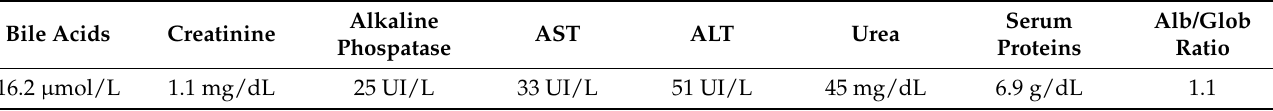
Table 1. Dog 1 biochemical parameters.